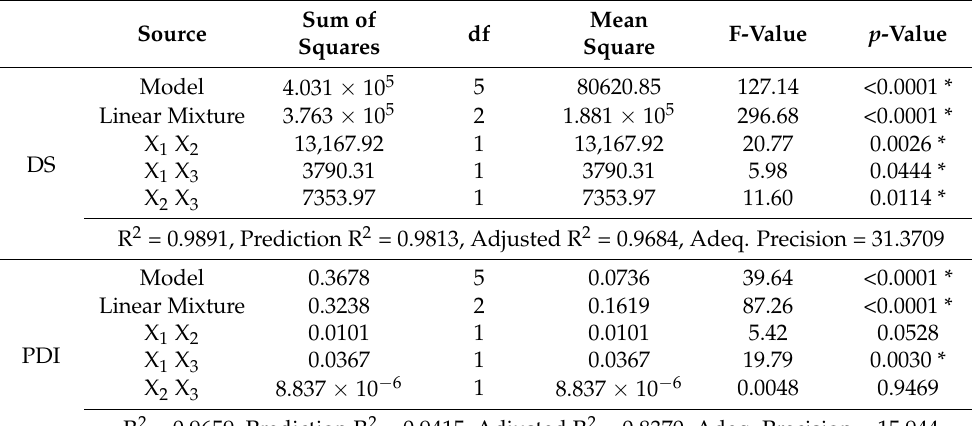
Table 4. ANOVA for dependent variables from simplex lattice design. Sum of Source